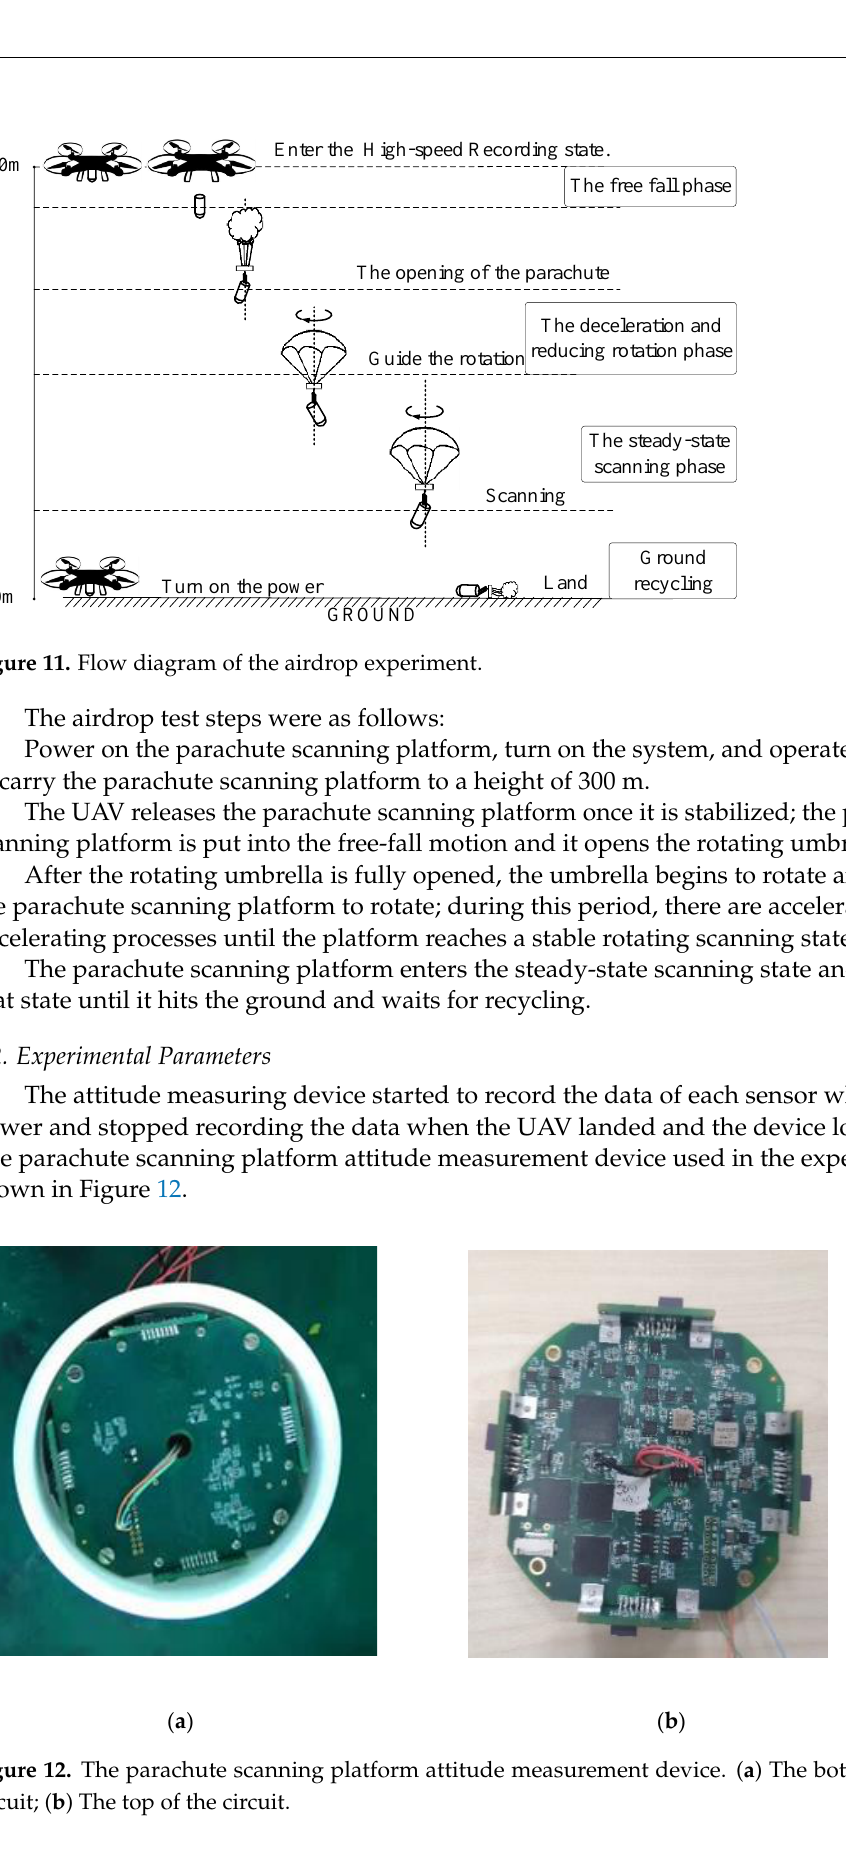
14 of 21 Figure 10. Scanning angular velocity of the semi-physical simulation. According to the semi-physical simulation results, the scanning angle converged to about 32°, the scanning angular velocity converged to about 2 rev/s, and the result coin- cided well with the simulation parameters. The results of the semi-physical simulation experiment showed that the proposed algorithm had high feasibility and accuracy. 5. Airdrop Experiment In order to simulate the motion environment of the terminal-sensitive projectile more realistically, an unmanned aerial vehicle (UAV) was used in the airdrop experiment. The parachute scanning platform with the installed attitude measuring device was trans- ported to the specified altitude by the UAV for the purpose of airdropping. After the ex- periment, the data recorded by the attitude measuring device were collected, and the pro- posed algorithm was used to process the collected data. The result was compared with the designed parameters. At the same time, the scanning angle, scanning angular velocity, and falling velocity of the parachute scanning platform were verified by video analysis.